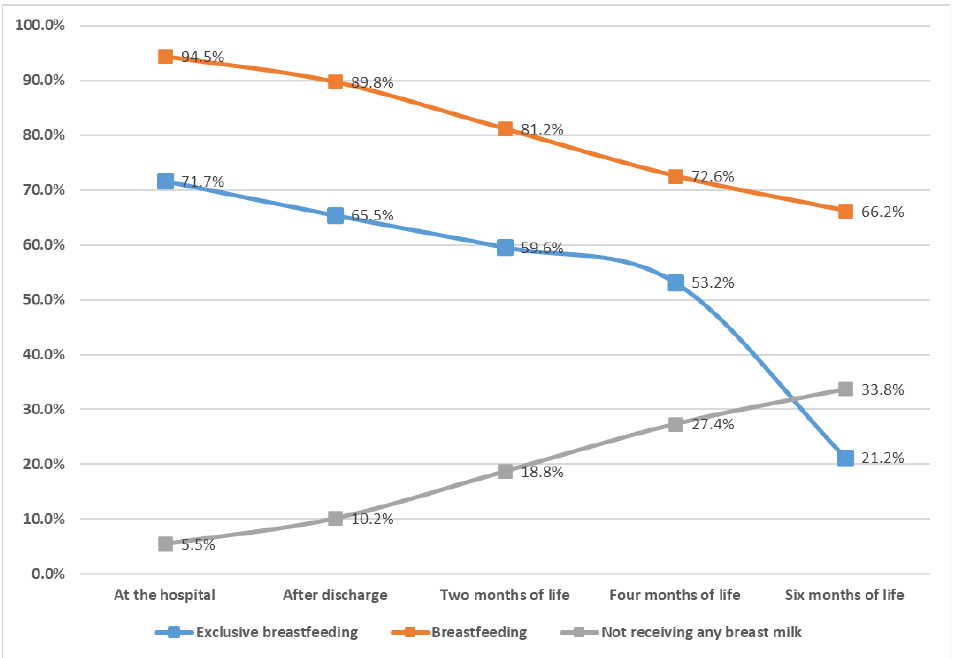
Figure 1. Breastfeeding indicators by infants’ age in the national breastfeeding prevelance study at baby friendly hospital in Greece.